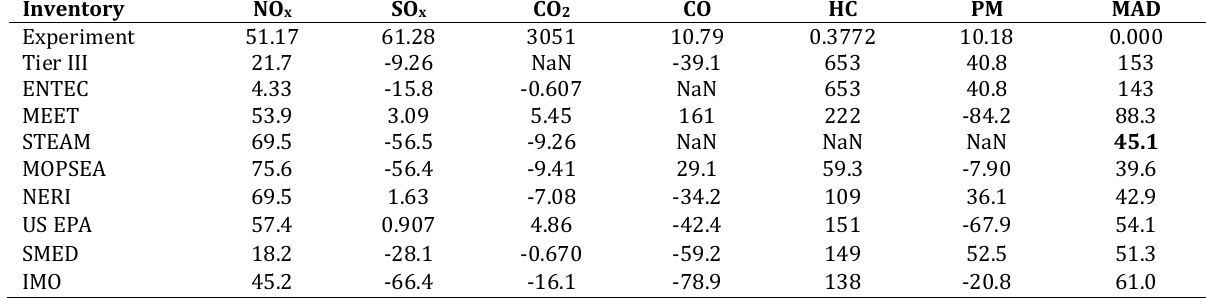
Table 7: Inventory deviations from the experimentally measured total emission amounts in % for the main engine at maneuvering. The experimental measurements are given in the second row in kg per time equal to the experiment duration according to the third column of Table 1. The mean absolute deviations in % are shown in the last